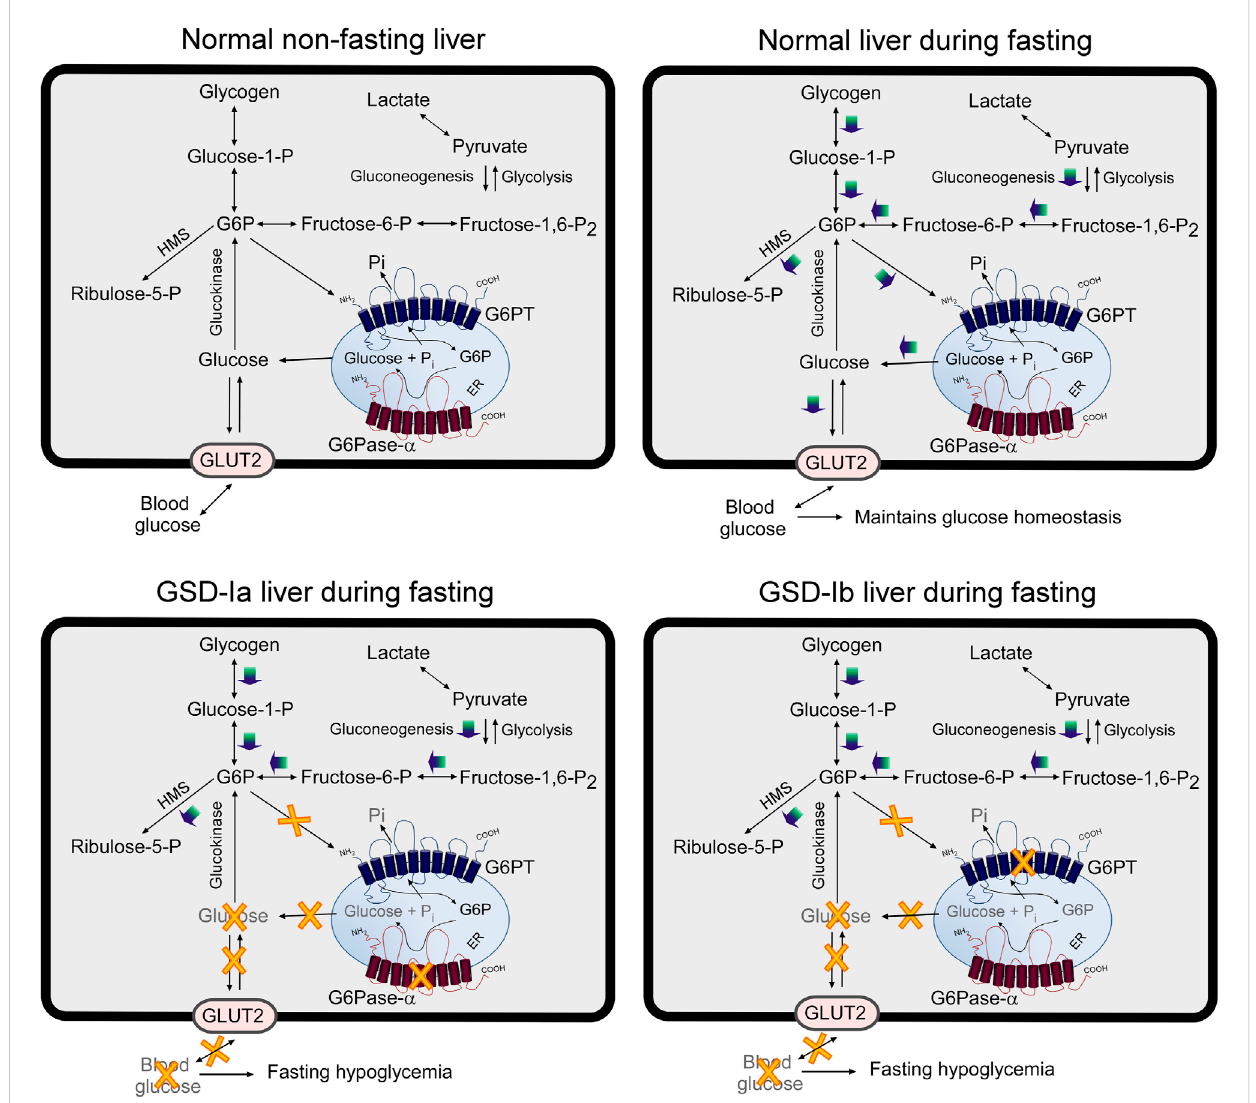
FIGURE 5 Pathways for G6P metabolism in normal, GSD-Ia, and GSD-Ib liver. During fasting, G6P, the end product of gluconeogenesis and glycogenolysis, is transportedfrom the cytoplasm into the lumen of the ERby G6PT. Inside theER, G6P is hydrolyzed by G6Pase- α and the resulting glucoseis transported backintothecytoplasmthenreleasedintothecirculationtomaintainbloodglucosehomeostasis.IntheGSD-Ialiver,whichlacksafunctionalG6Pase- α , the co-dependent G6PT loses activity (Lei et al., 1996) and cytoplasmic G6P is not transported ef fi ciently into the ER. Any G6P resident in the ER cannot be converted to glucose, resulting in a failure to release glucose to the blood, leading to hypoglycemia following a short fast. In the GSD-Ib liver, which lacks a functional G6PT, G6P cannot be transported into the ER for glucose production by G6Pase- α , leading to hypoglycemia following a short fast(Chenetal.,2003).TheGLUT2,responsibleforthetransportofglucoseinandoutofthecell,isshownembeddedintheplasmamembrane.G6PTand G6Pase- α are shown embedded in the ER membrane. HMS, hexose monophosphate shunt; GLUT2, glucose transporter